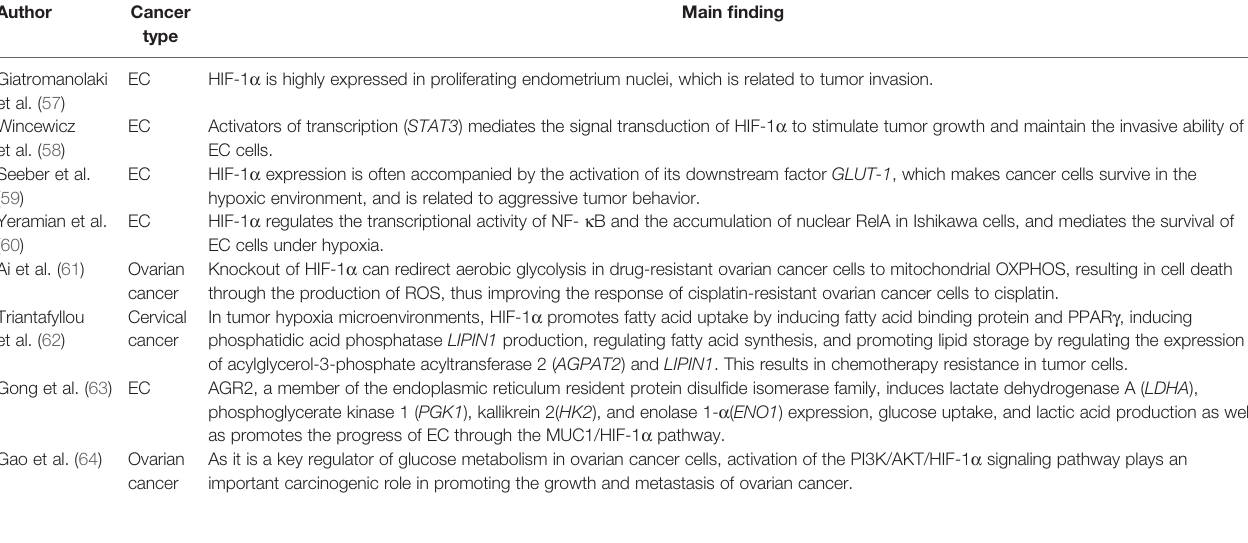
TABLE 1 | Studies on HIF-1 a regulation of glucose and lipid metabolism and promotion of gynecological malignant tumor